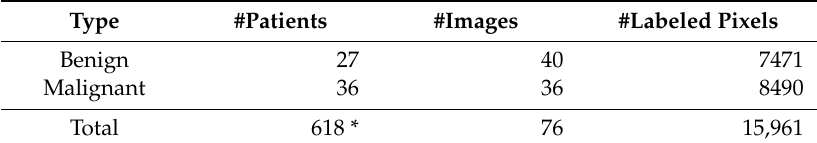
Figure 2. Patient/image flow scheme in this study. n : number of patients; m : number of HS images. Table 1. HS Dermatological Labeled Dataset.